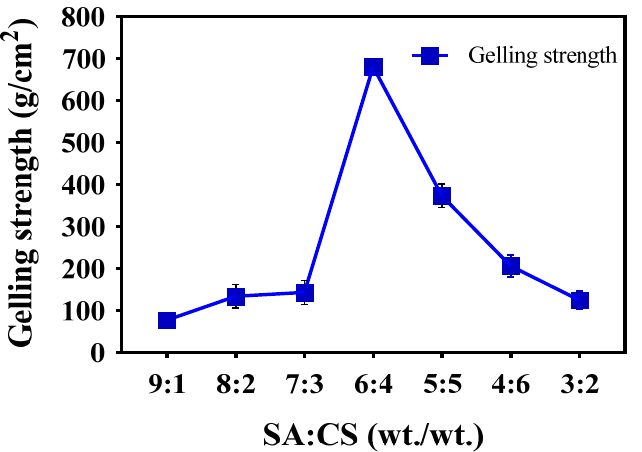
Figure 1. The strength of SCT-0 hydrogel peaked when the mass ratio of SA:CS was 6:4. The influence of SA:CA mass ratio on the gelling strength of the prepared hydrogel was examined using the TMS-Pilot texture analyzer. n = 3, data are presented as means ±